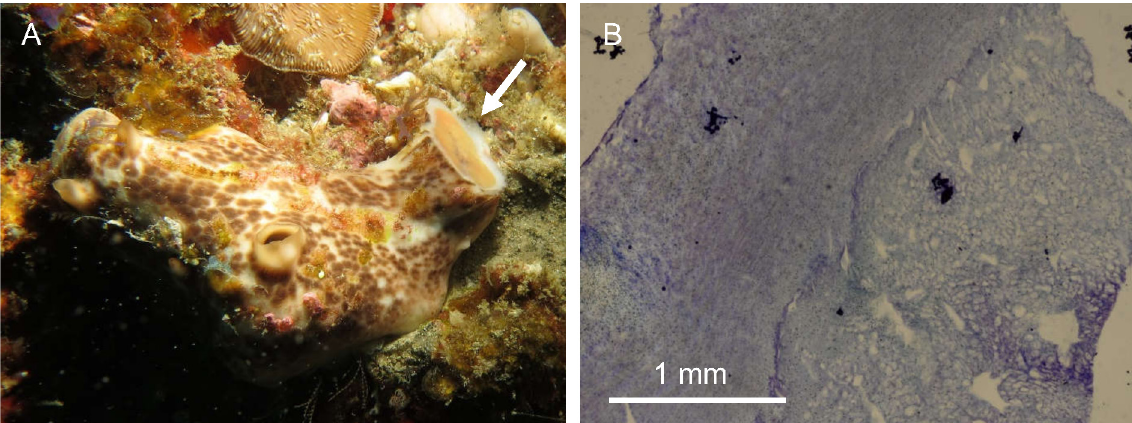
Fig. 2. Chondrosia corticata Thiele, 1900. A . Specimen (PO7) in situ . The arrow points a fresh cut showing the sponge’s thick ectosome. B . Histological section showing the thick ectosome and the cavernous